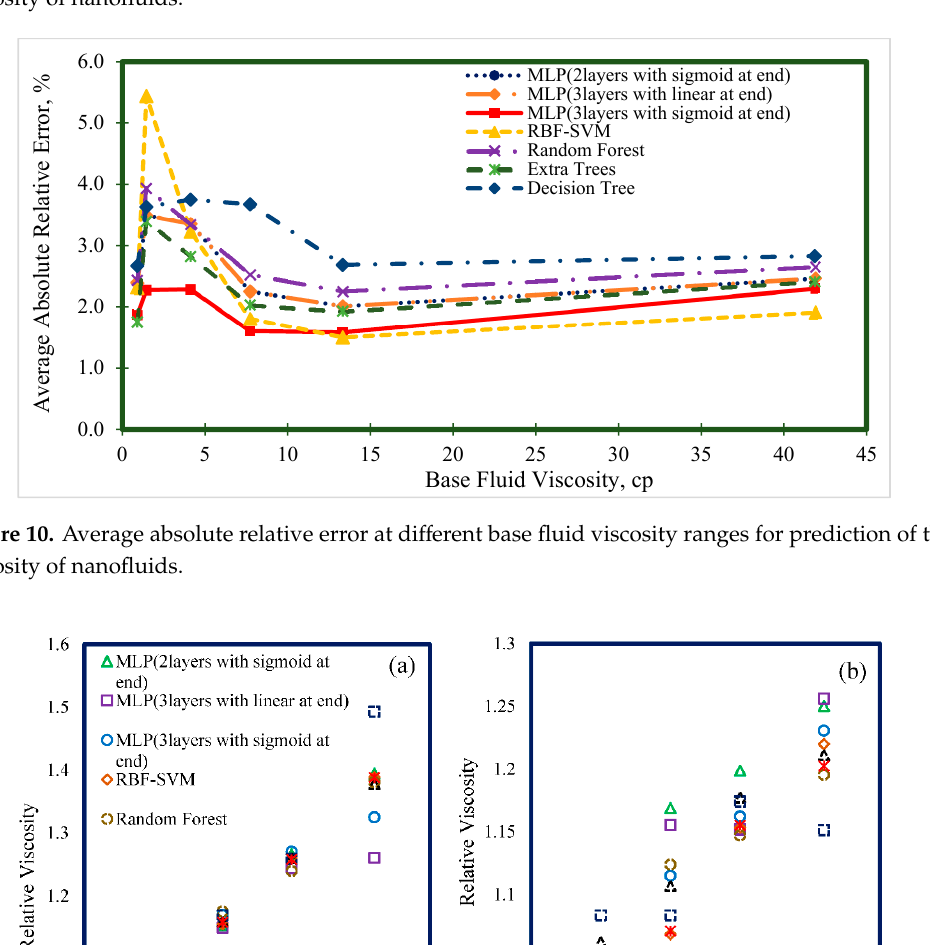
Figure 9. Average absolute relative error at different nanoparticle density ranges for prediction of the viscosity of nanofluids.